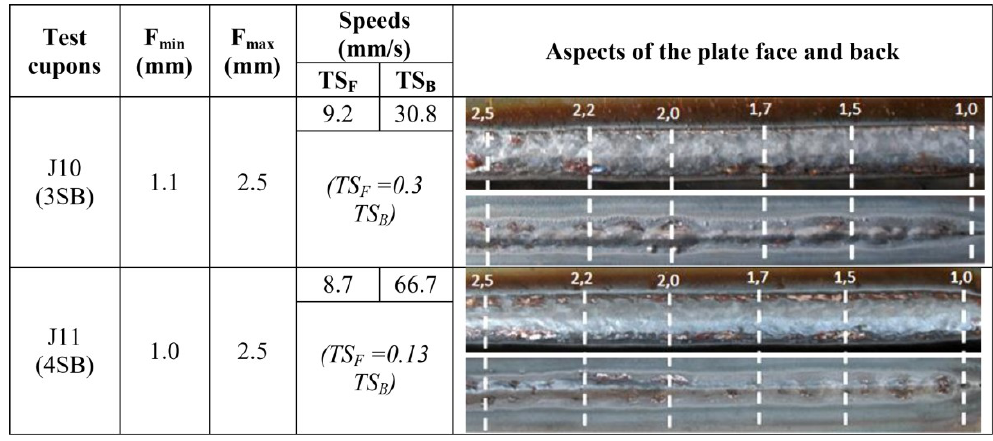
Figure 7. Quantification of the operational gap range for experiments 5SB and 6SB (switchback torch movement), where TS F > TS B . Table 5 displays a summary of the root gap ranges with full penetration for each tested condition. As seen in the mentioned table, in terms of root gap tolerance for the switchback conditions, the welded joints with a forward stroke speed lower than the backward stroke speed (3SB and 4SB) were those that presented root passes which were more stable, yet at the same level as one of the conditions with forward stroke speed equal to the backward stroke speed (1SB) and the condition with without application of the switchback (1L). On the other hand, based on results from elsewhere, improvements could be made through slight adjustments of the switchback parameters. According to the simulations carried out by Kaneko et al. [5,6], also in thin plate butt welding, and the results obtained by Schwedersky et al. [14], using GTAW at high currents, if the backward stroke length became longer than half of the forward stroke length (B > F/2), continuous root passes could